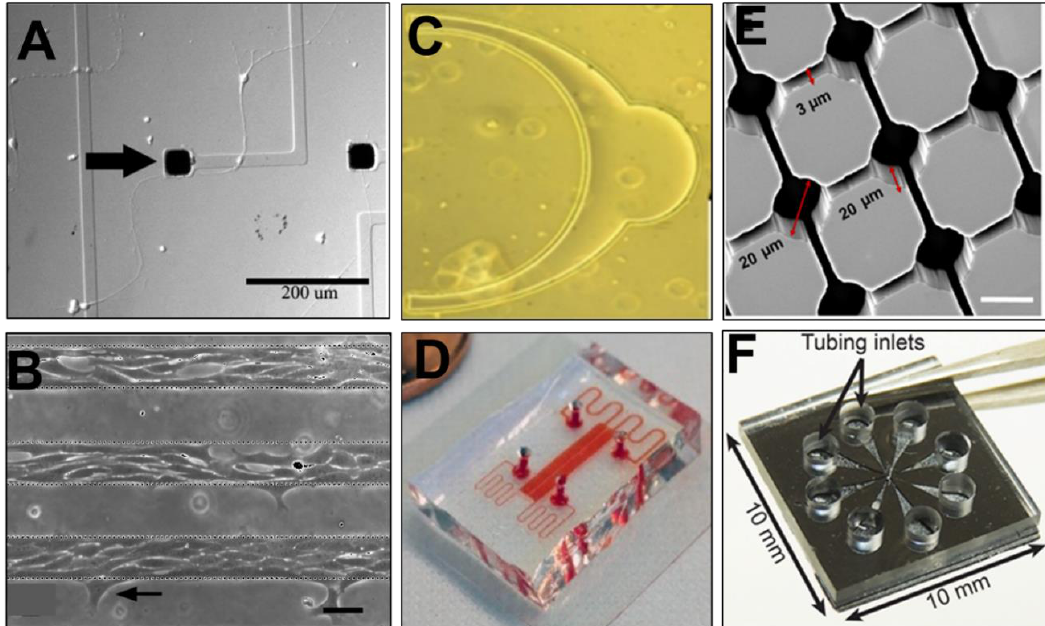
Figure 6. Selection of contemporary, microfluidic and microscale assays developed for bioengineering study of the visual system. ( A ) A micropatterned substrate illustrating the growth and guidance of retinal ganglion axons towards electrodes with and without substrate protein conjugation (image reproduced with permission from [249]). ( B ) Retinal cells growing preferentially on a poly (dimethyl) siloxane (PDMS) substrate whose surface is functionalized with patterned layers of polyelectrolyte multilayers (image reproduced with permission from [59]). ( C ) A microfluidic anatomical model, called the μ-Retina, designed to produce concentration gradients of chemoattractants for retinal stem-like cells using in vivo scale and spherical geometries (image reproduced with permission from [219]). ( D ) A microfluidic device, called the Gal-Mμs system, which employs microfluidic channels, nanoarrays, and electrical stimulation to stimulate motile and adhesive behaviors of photoreceptor precursors (image reproduced with permission from [223]). ( E ) A neural network chip, called the NN Chip, comprised of interconnected microwells to examine photoreceptor connectivity and apoptosis (image reproduced with permission from [244]). ( F ) A microfluidics-based, synapse chip used for neurotransmitter modulation of explanted retina (image reproduced with permission from [248]).